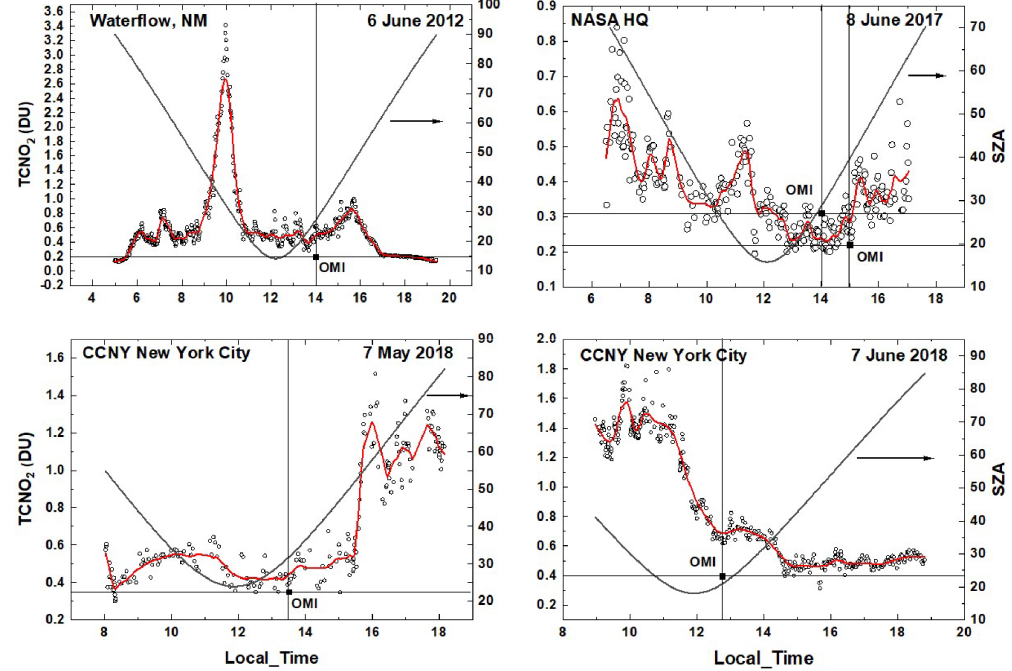
Figure 6. Diurnal variation of TCNO 2 on a single day (1) 2km north of Waterflow, NM, near a power plant, (2) on the roof of NASA Headquarters in Washington DC, and (3) on the roof or a building at CCNY City College of New York, New York